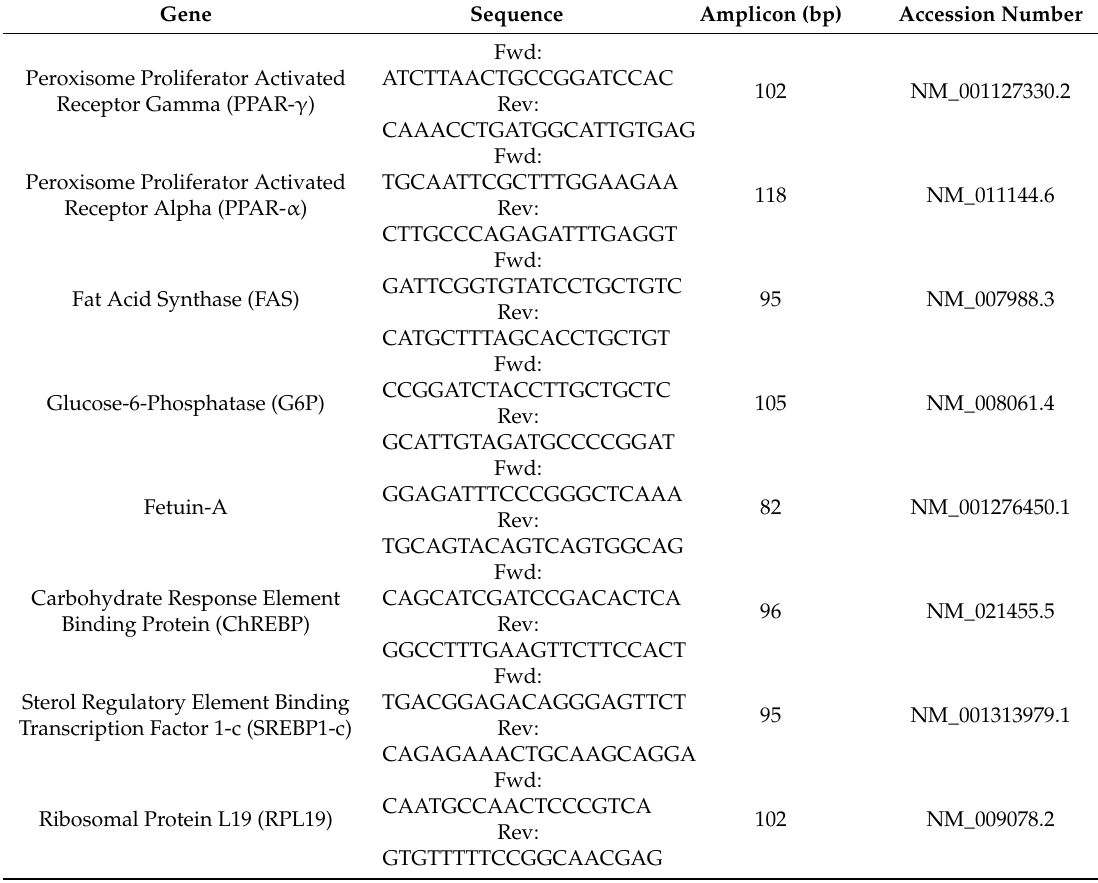
Table 1. Table 1. Sequence of the oligonucleotides used in